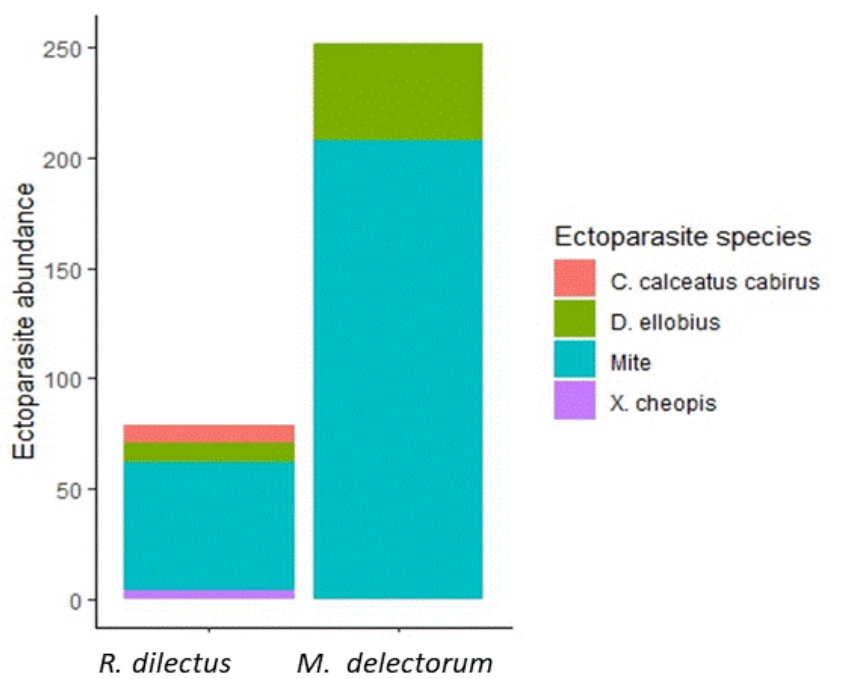
Figure 5. Relative contributions of flea and mite species infesting M. delectorum and R. dilectus on Mount Meru, Tanzania.